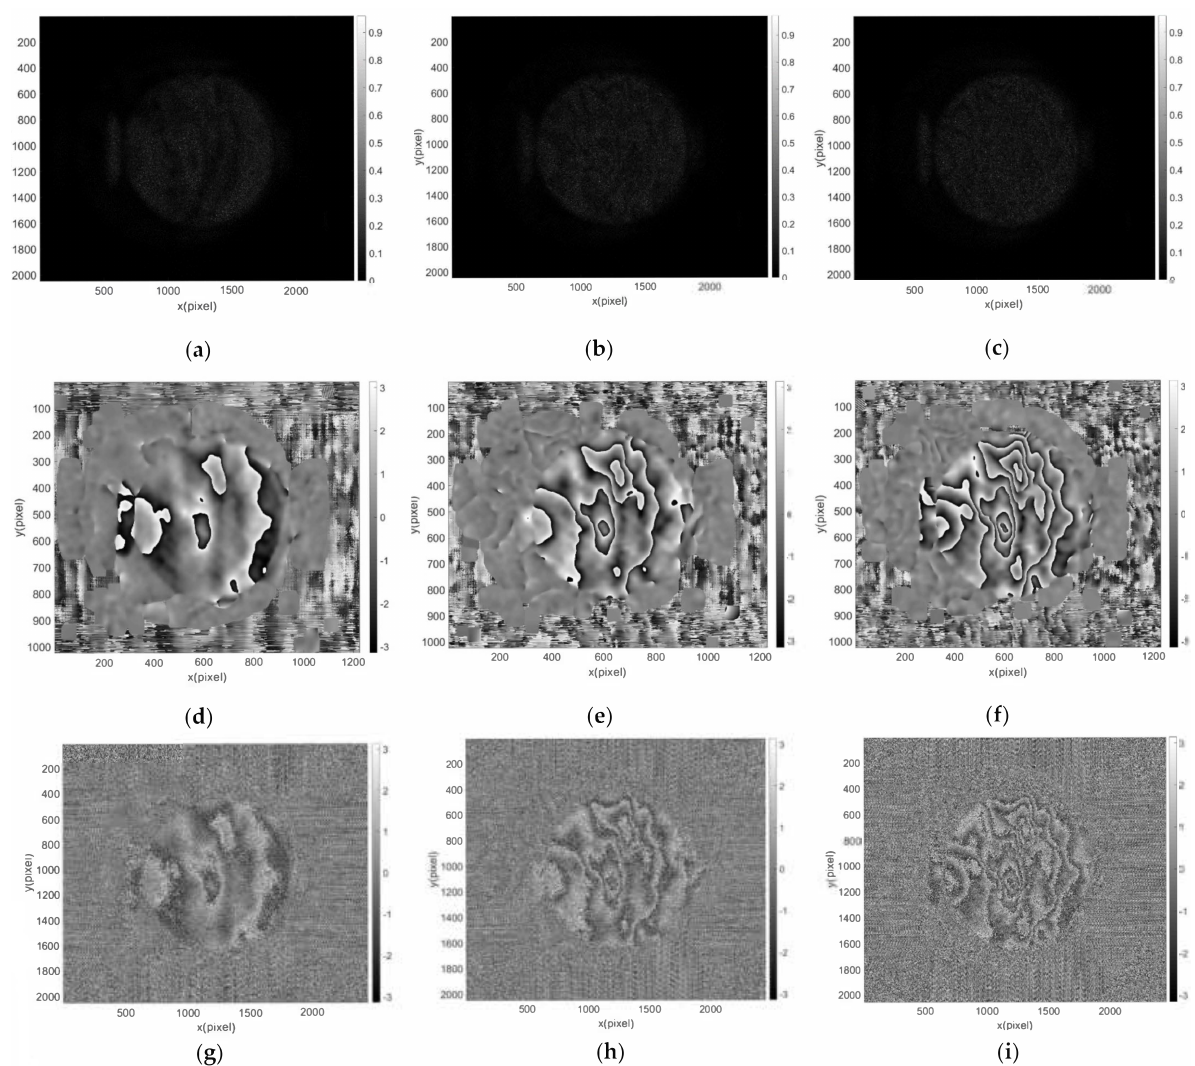
Figure 11. Results derived at three time instants for defect 2 on WTB; ( a – c ) Fringe patterns corresponding to the time instants of 65th frame, 130th frame, and 200th frame; ( d – f ) Phase maps derived with the proposed method at the instants of . . . ∆ φ ∆ φ ∆ φ 65th frame ( t 65 ), 130th frame ( t 130 ), and 200th frame ( t 200 ); ( g – i ) Phase maps derived without going through WFF filter at time instants of 65th frame ( ∆ φ t ), 130th frame ( ∆ φ t ), and 200th frame ( ∆ φ t 65 200 130